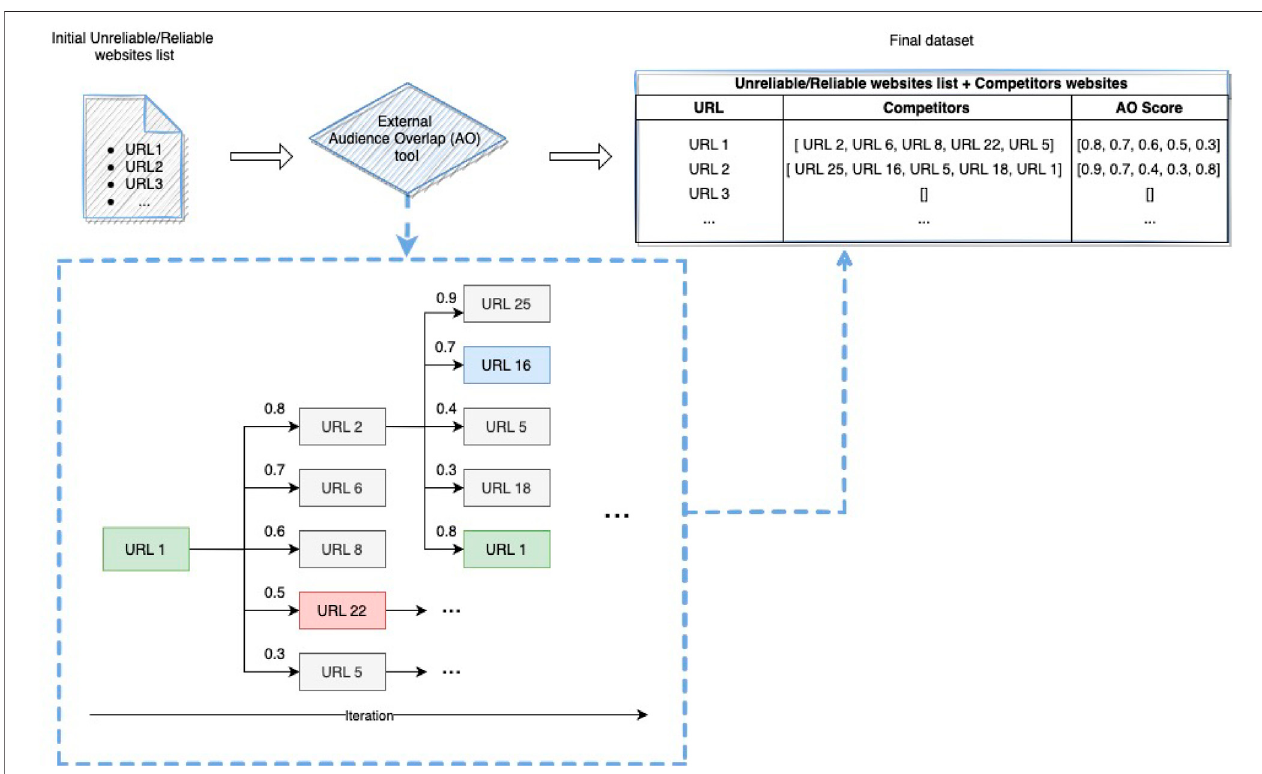
FIGURE 1 | Data collection process. For each individual URL included in the list of reliable/unreliable websites (targets), competitors are extracted using external audience overlap (AO) tools. For each competitor extracted, the AO score, namely, an indicator of the similarity level between the competitor and the target, is also collected. The process for extracting AO information is repeated iteratively for each competitor, extracted at each iteration. Due to the exponential growth in the website population through iterations, we set a threshold ( n iter = 6) to stop the process.